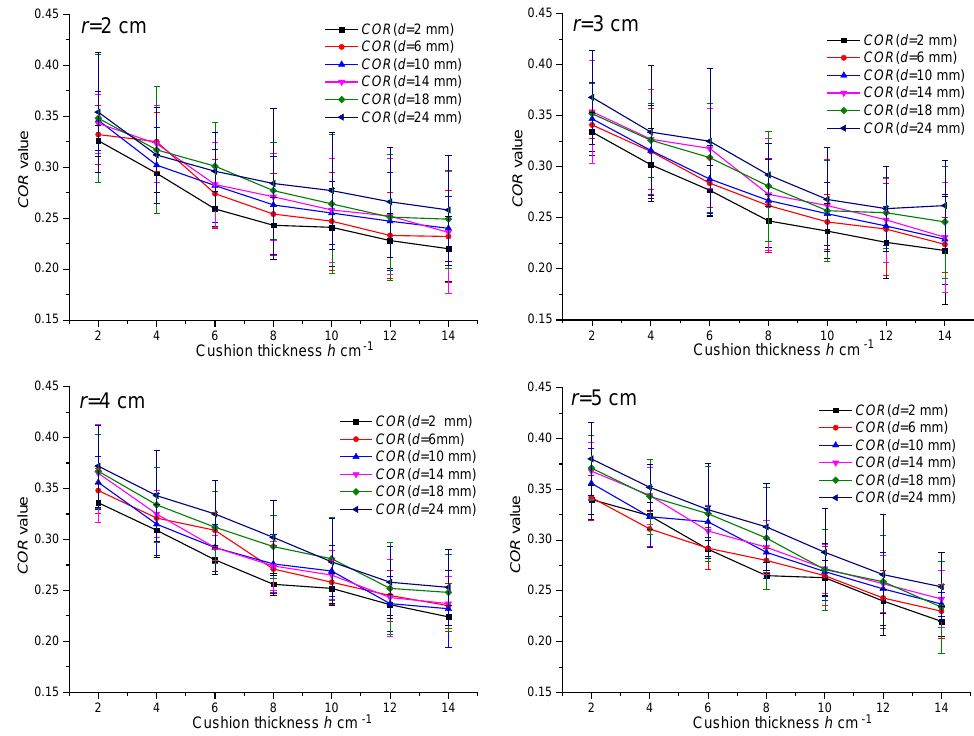
Figure 6. Comparison of the COR of blocks of different radii released from a height of 1.2m.